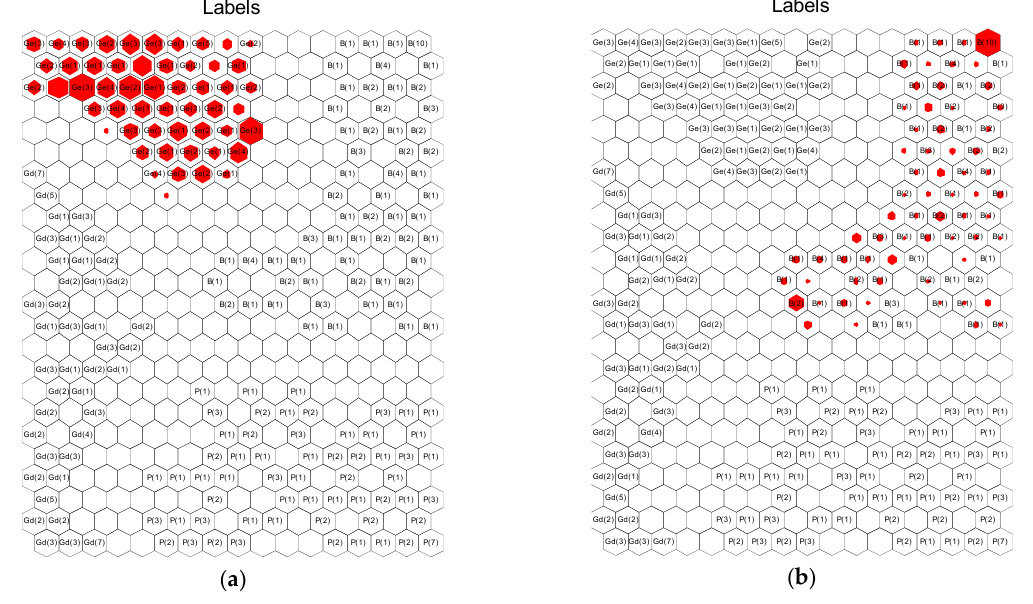
Figure 7. Test data mapping results. ( a ) test (general); ( b ) test (best).